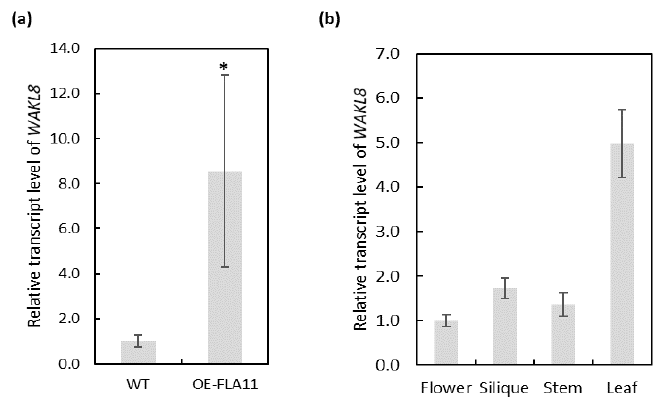
Figure 2. Q-PCR analysis of WAKL8 transcript levels in OE-FLA11 stems and expression profile in WT tissues. ( a ) Q-PCR analysis showed upregulation of WAKL8 transcript in OE-FLA11 stems compared with that in WT stems. ( b ) Q-PCR analysis showed WAKL8 is ubiquitously expressed in different tissues but highest in leaves. Data shown as average ± SD. n ≥ 3 plants acquired from 3 biological replicates. * Significant difference compared with WT plants, p < 0.05 using Student’s t -test.